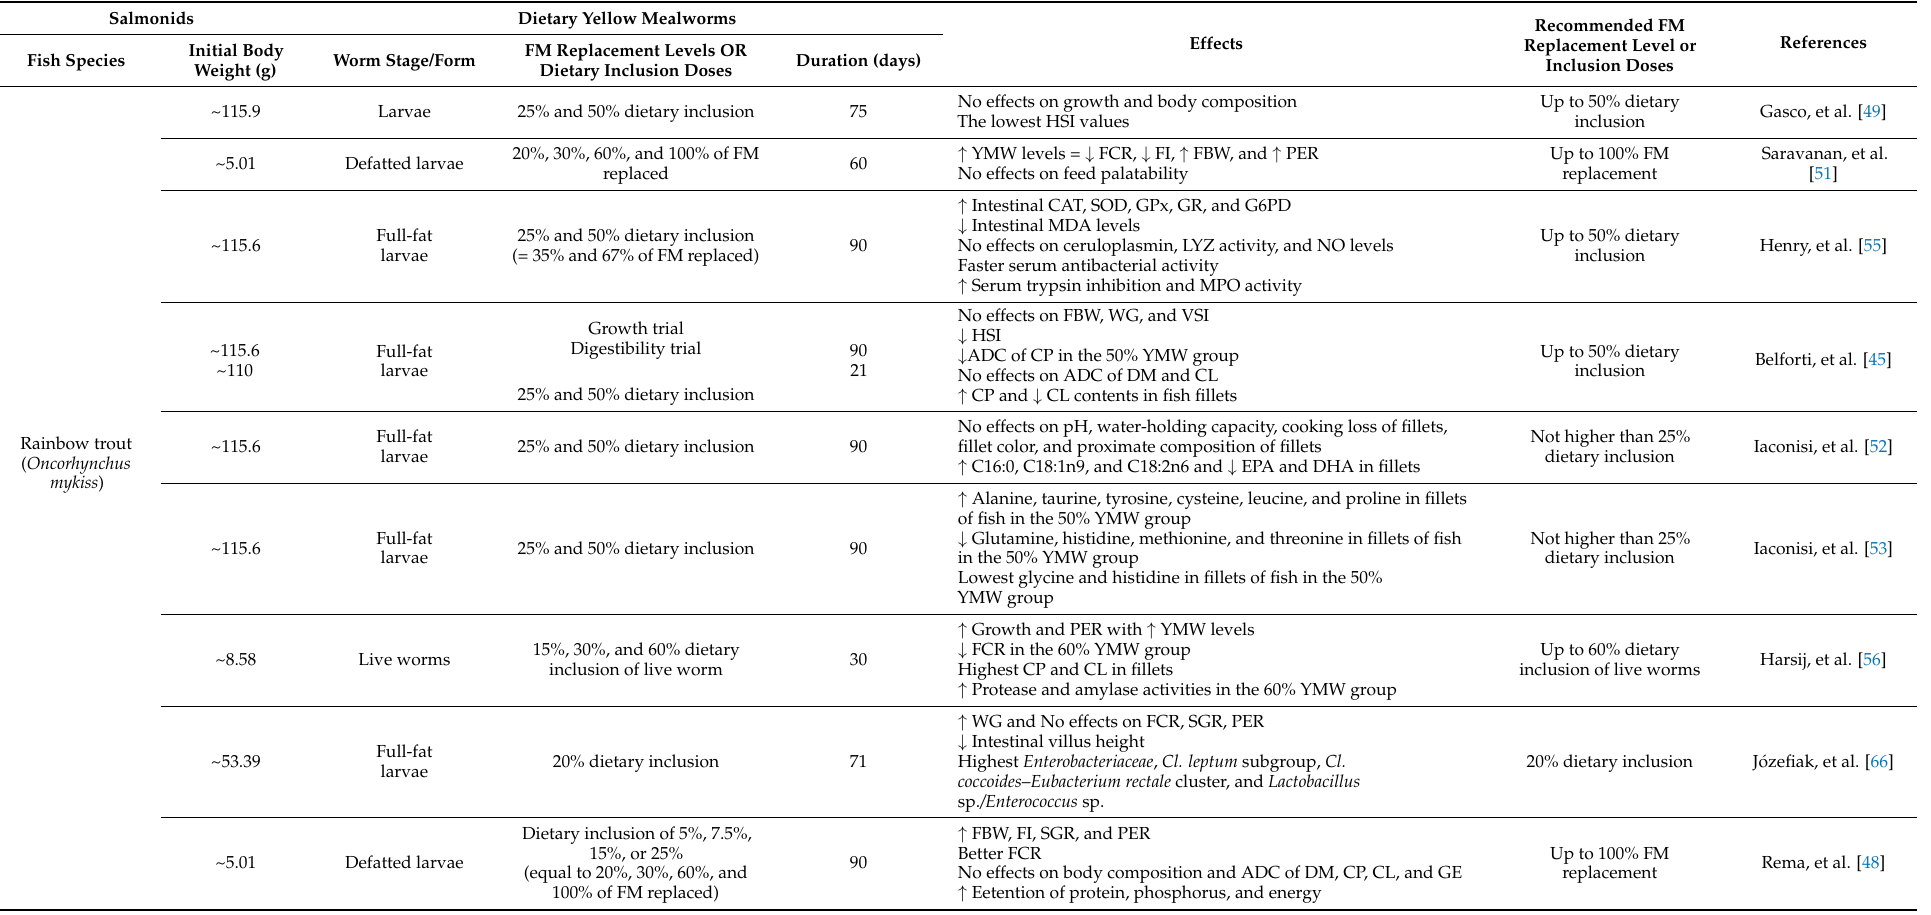
Table 4. Application and effects of using the yellow mealworm ( Tenebrio molitor ) in diets of